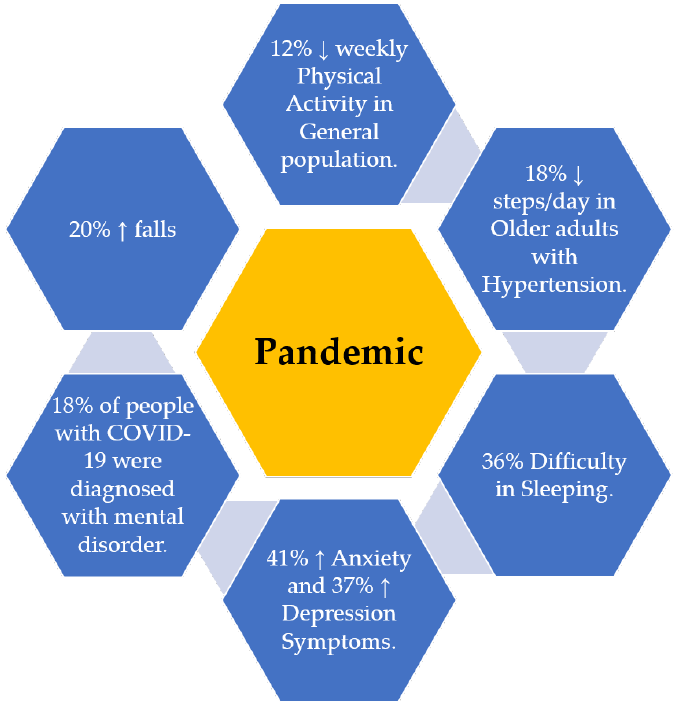
Figure 1. Summarized representation of studies which investigated the impact of the COVID-19 pandemic on physical activity, sleep, and mental health. These studies highlighted that, during the COVID-19 pandemic, the activity level has been reduced in both the general population [10] and those with chronic illness (e.g., hypertension) [11], and sleep quality has deteriorated [12]. Other studies suggested that during the pandemic, depression, anxiety, and mental health disorder have been increased compared to pre-pandemic [9,13,14]. However, these studies were limited to create a link between changes in the pattern of physical activities and sleep with changes in depression symptoms in the context of a prospective study design.